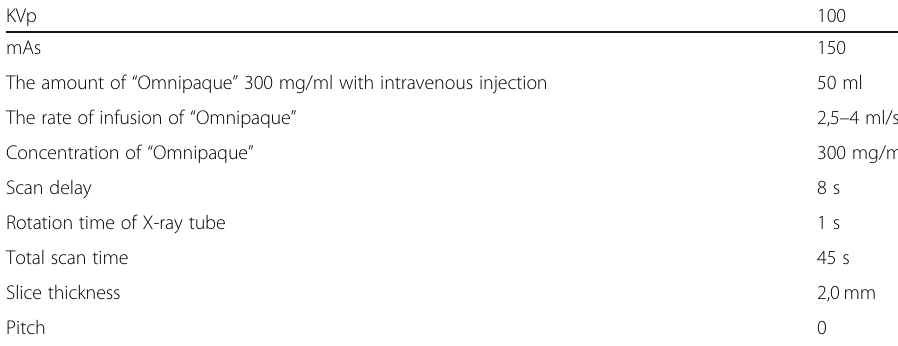
Table 1 Technical parameters of CT perfusion of the liver KVp 100 mAs 150 The amount of “ Omnipaque ” 300 mg/ml with intravenous injection 50 ml The rate of infusion of “ Omnipaque ” 2,5 – 4 ml/s Concentration of “ Omnipaque ” 300 mg/ml Scan delay 8 s Rotation time of X-ray tube 1 s Total scan time 45 s Slice thickness 2,0 mm Pitch